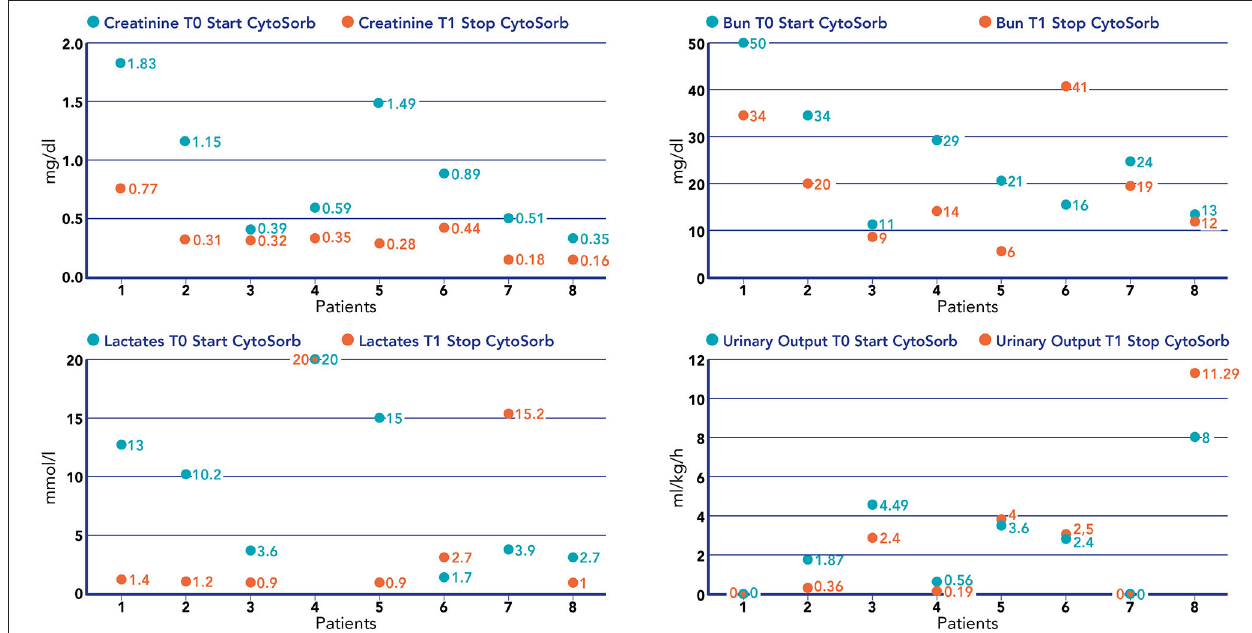
FIGURE 4 | Values of creatinine (mg/dl), BUN (mg/dl), lactate (mmol/L), and urinary output (mL/kg/h) before the start of hemoperfusion with CytoSorb and after the stop of hemoperfusion with CytoSorb in each patient treated.